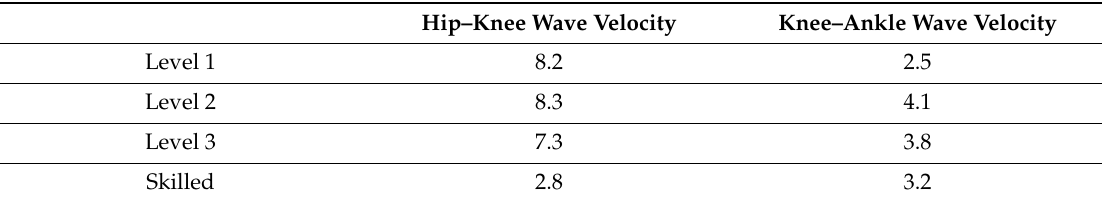
Table 3. Mean body wave velocities of the flutter kick obtained in the Sanders [13] study of three levels of learners and a group of skilled